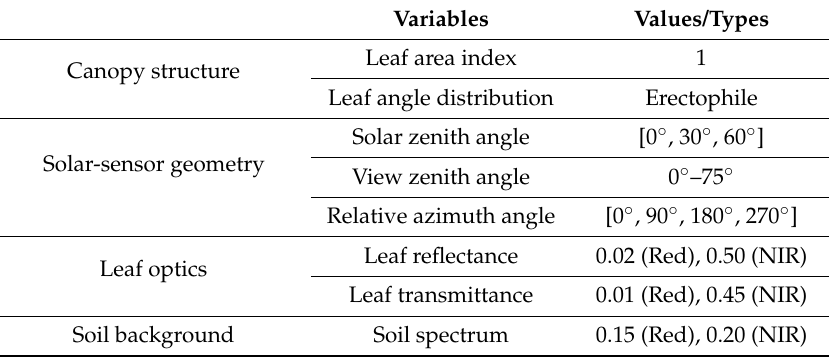
Table 1. Canopy structural and leaf optical parameters of the “validate” mode in the RAMI platform